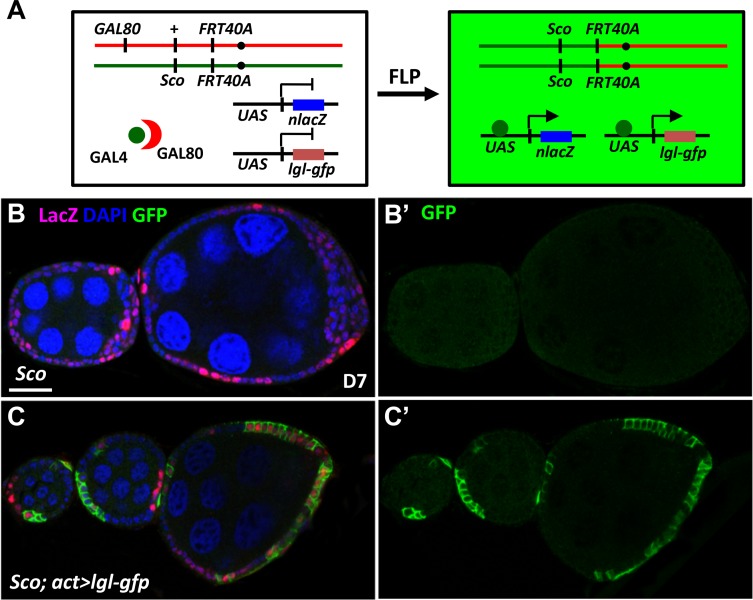
Exogenous supplement of lgl prevents Sco follicle cells forming multiple layers.(A) Mosaic Analysis with Repressible Cell Marker (MARCM) was used to generate Sco homozygous mutant cells expressing lgl-gfp. Females carried wild-type alleles linked to tubulin promoter-GAL80 (a GAL4 suppressor) in trans with the Sco mutant allele on the second chromosome, actin promoter-GAl4, UAS-nuclear (n) LacZ and UAS-lgl-gfp on the third chromosome. FLP-mediated recombination between two FRT sites during mitotic division generated Sco homozygous mutant cells lacking GAL80, allowing UAS-trangenes to be expressed by GAL4 driven by an actin promoter. (B-C) Mosaic egg chambers in one-week (W)-old Sco mutant (B), and Sco mutant with lgl overexpression: LacZ (green, mutant cells) and DAPI (blue, DNA). Dashed lines mark follicle cell clones. The scale bar is 20 μm. The genotype of B is hs-flp/+; tub-Gal80FRT40A/ ScoFRT40A; act-GAL4UAS-nlacZ/+, and of C is hs-flp/+; tub-Gal80FRT40A/ ScoFRT40A; act-GAL4UAS-nlacZ/UAS-lgl-gfp.